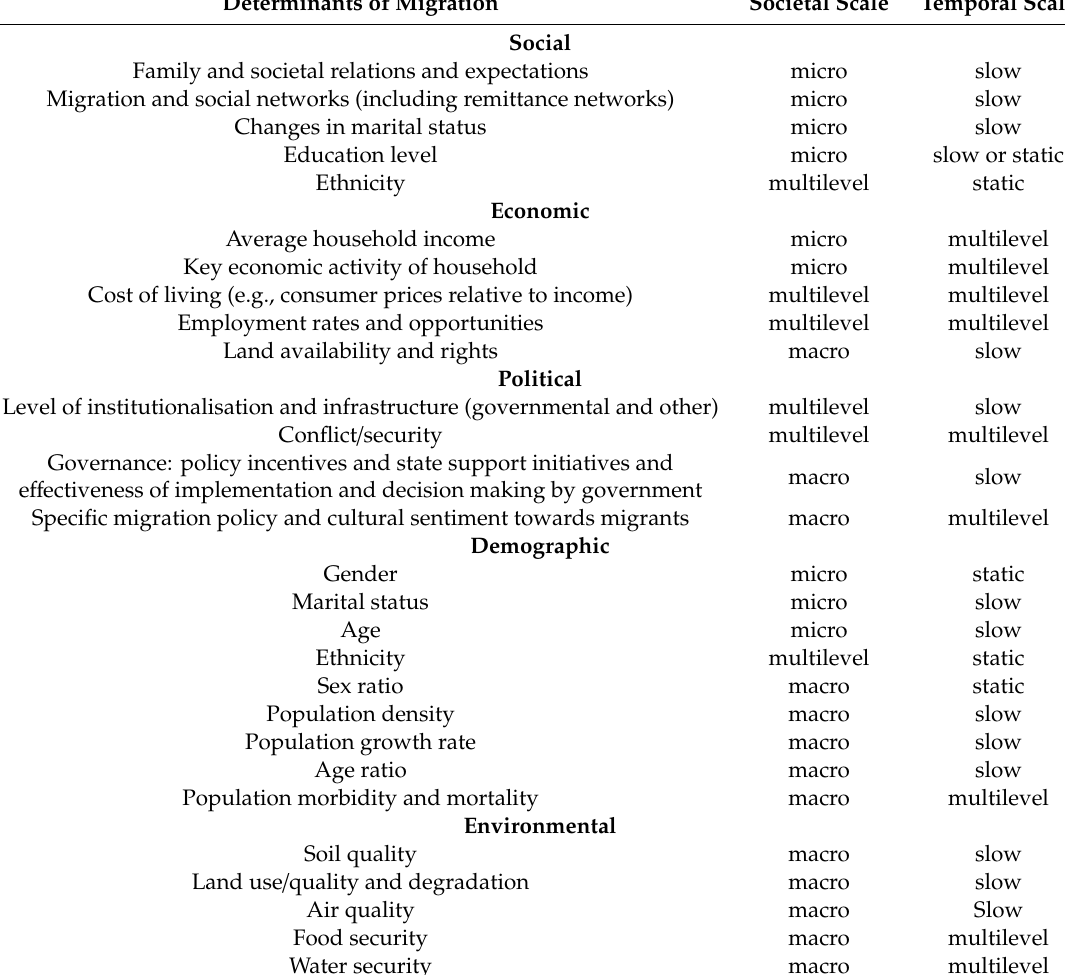
Table 3. Non-climatic drivers of migration. Drivers are split into five classes: social, economic, political, demographic and environmental. Societal level refers to the societal scale at which drivers typically impact. Some drivers may exist both as micro and macro factors. Temporal scale refers to the typical timescale of change in each driver. Whilst there is no set demarcations, slow change refers to a change typically over years or decades and change fast refers to changes which may occur immediately or over a short timeframe of months. Static implies that factor is not usually time